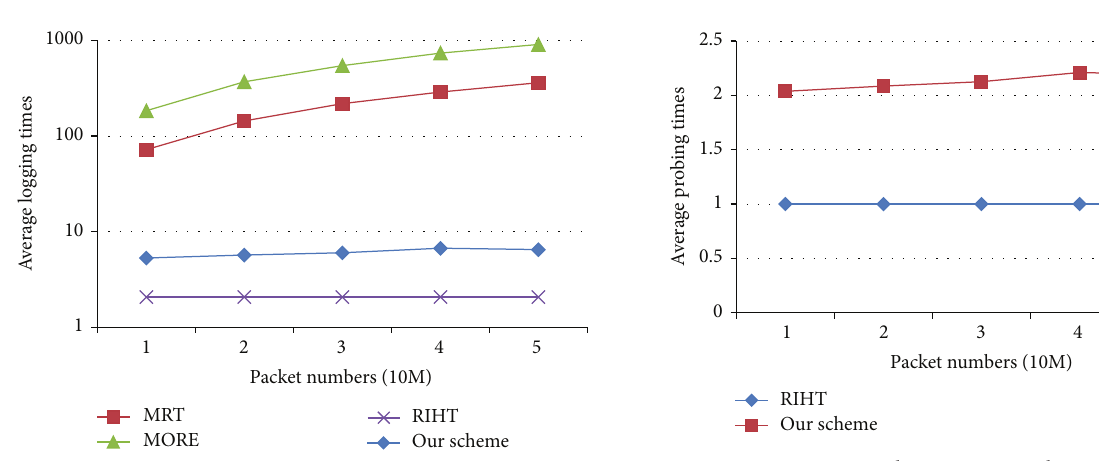
Figure 9: Average probing times in path